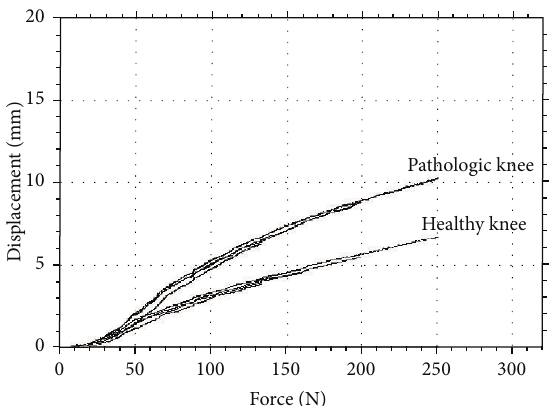
Figure 1: Preoperative anterior laximetry: graph of GNRB measure- ments.